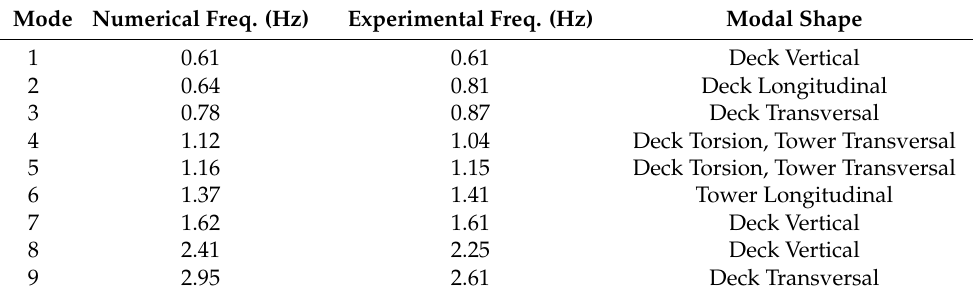
Table 9. Modal characteristics from numerical model and experimental analysis. Mode Numerical Freq. (Hz)